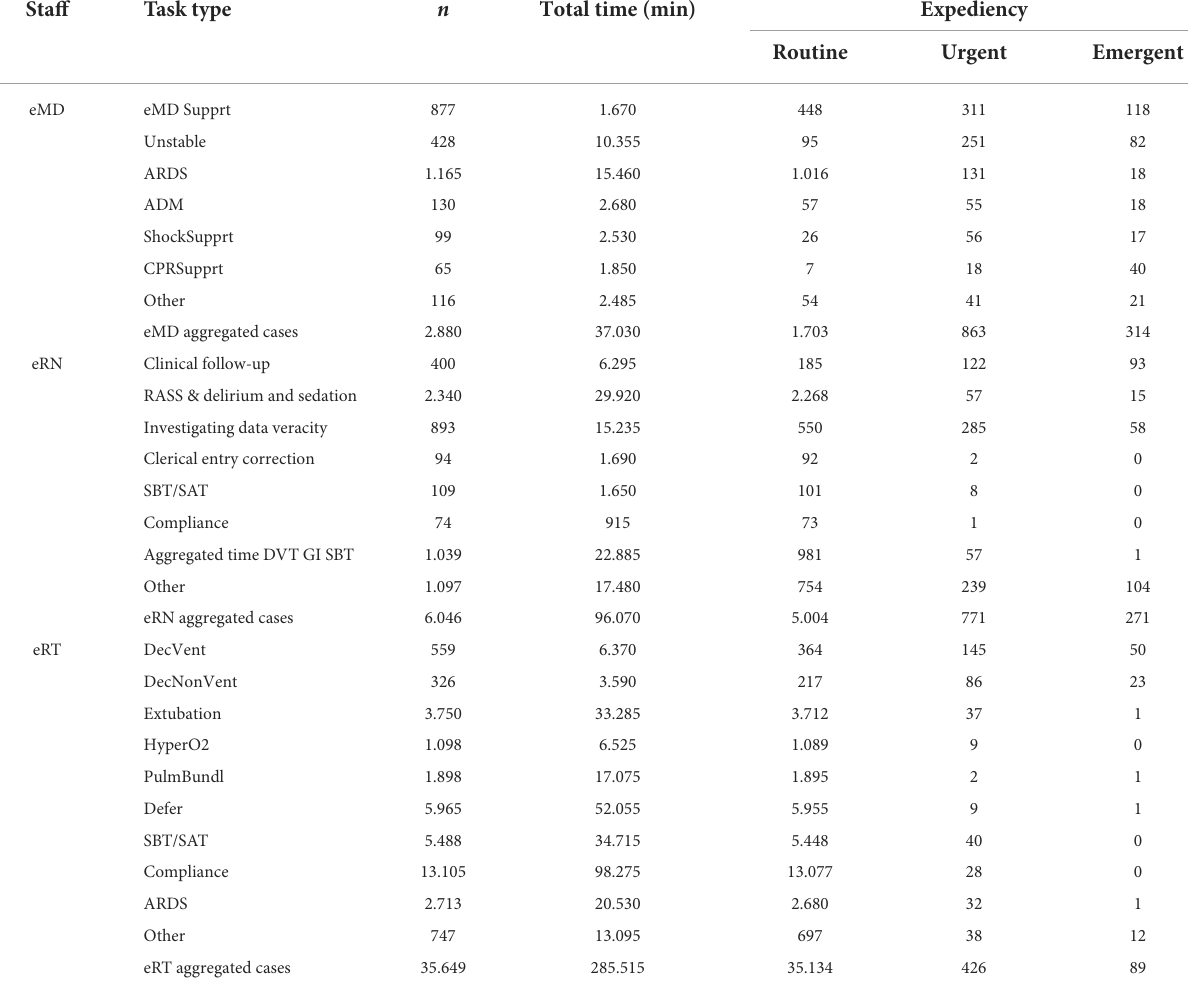
TABLE 1 Task breakdown per each specialty based on expectancy and total time spent in minutes.